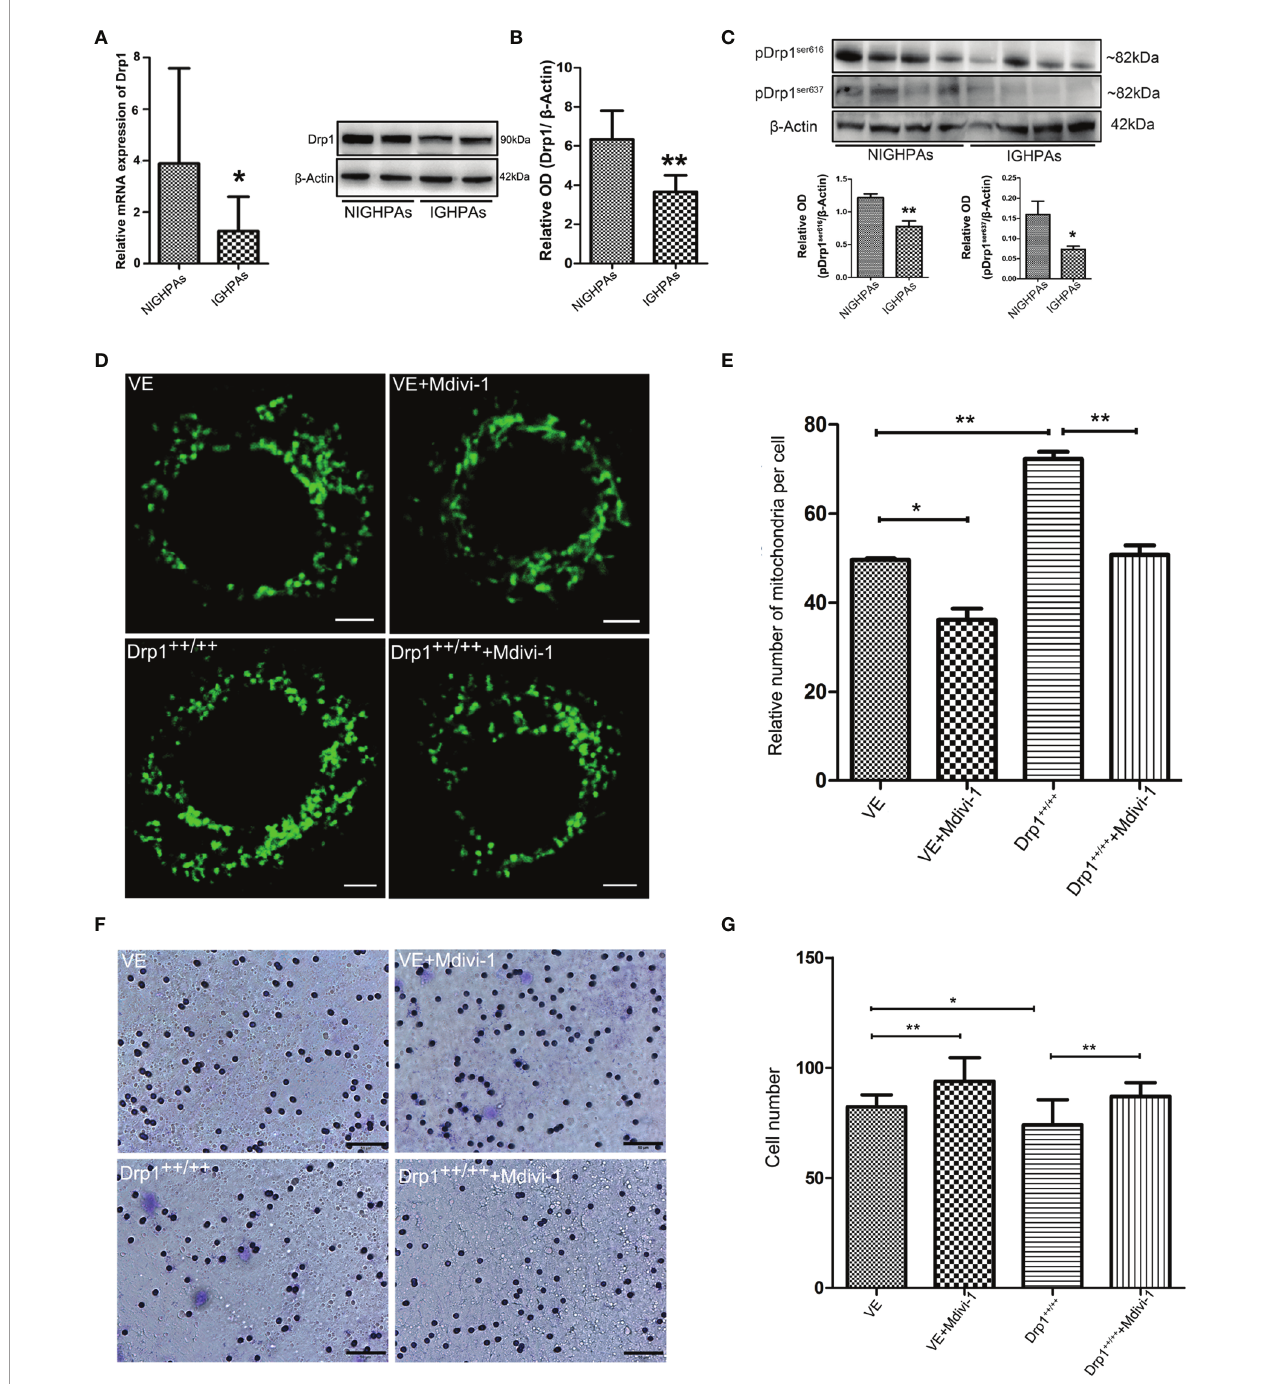
FIGURE 2 | The relationship between Drp1 regulated mitochondrial dynamics and tumor invasion. (A) Expression of Drp1 mRNA was assessed by RT-qPCR in NIGHPAs (n = 12) and IGHPAs (n = 13) samples. (B) Expression of Drp1 protein levels in NIGHPAs (n =8) and IGHPAs (n =8) samples was assessed by western blotting (left panel). Statistical analysis of the western blotting results (right panel). (C) Protein levels of phosphorylated Drp1at Ser616 and Ser637 in NIGHPAs and IGHPAs samples were assessed by western blotting (above panel). Statistical analysis of the western blotting results (below panel). (D) Mitochondria were stained with Mito-Tracker Green FM to display quantity and mitochondrial morphology in four GH3 cell lines groups, VE (transfected with empty vector) group, VE+Mdivi-1 group, Drp1 ++/++ (Drp1 over expression vector) group, Drp1 ++/++ +Mdivi-1 group. GH3 cells were observed after intervention with Mdivi-1 for 48 hours by confocal microscope. Scale bar = 2.5 um. (E) Statistical analysis of the relative number of mitochondria per cell (n = 25). (F) The invasive ability of GH3 cells was evaluated by transwell assay (n = 3). Scale bar = 50 um. (G) Statistical analysis of the invasive GH3 cell number. *P < 0.05, **P <